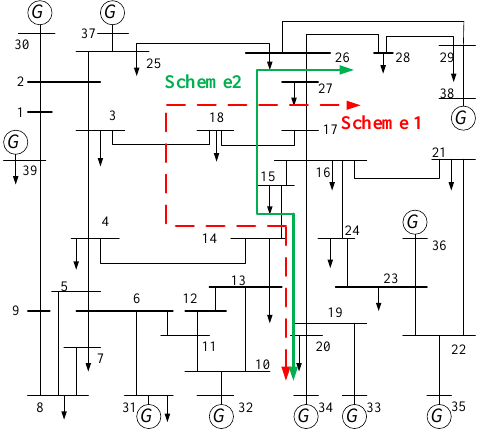
Figure 8. Optimal islanding surface (case 1).